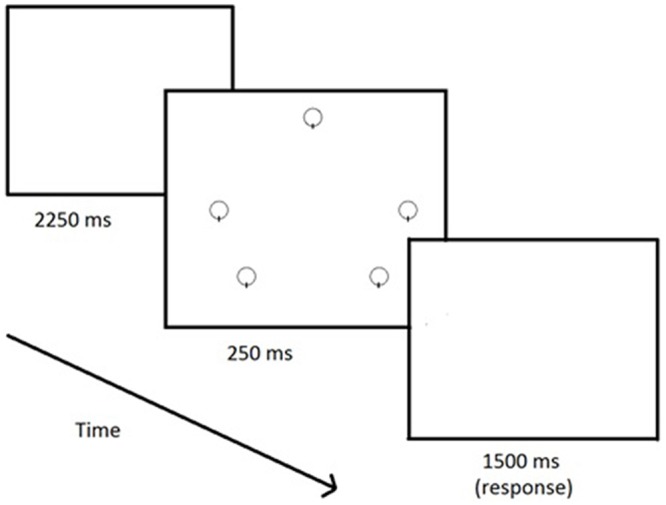
Graphical depiction of a neutral trial.